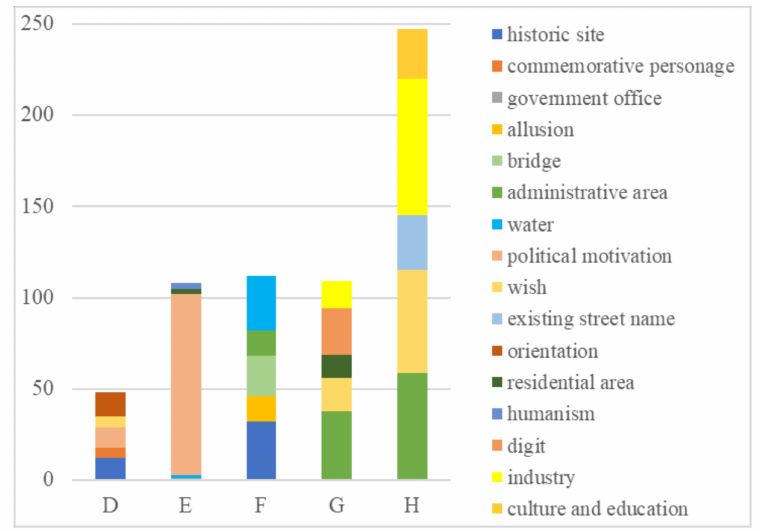
Figure 7. Main types and quantities of changed street names in time periods